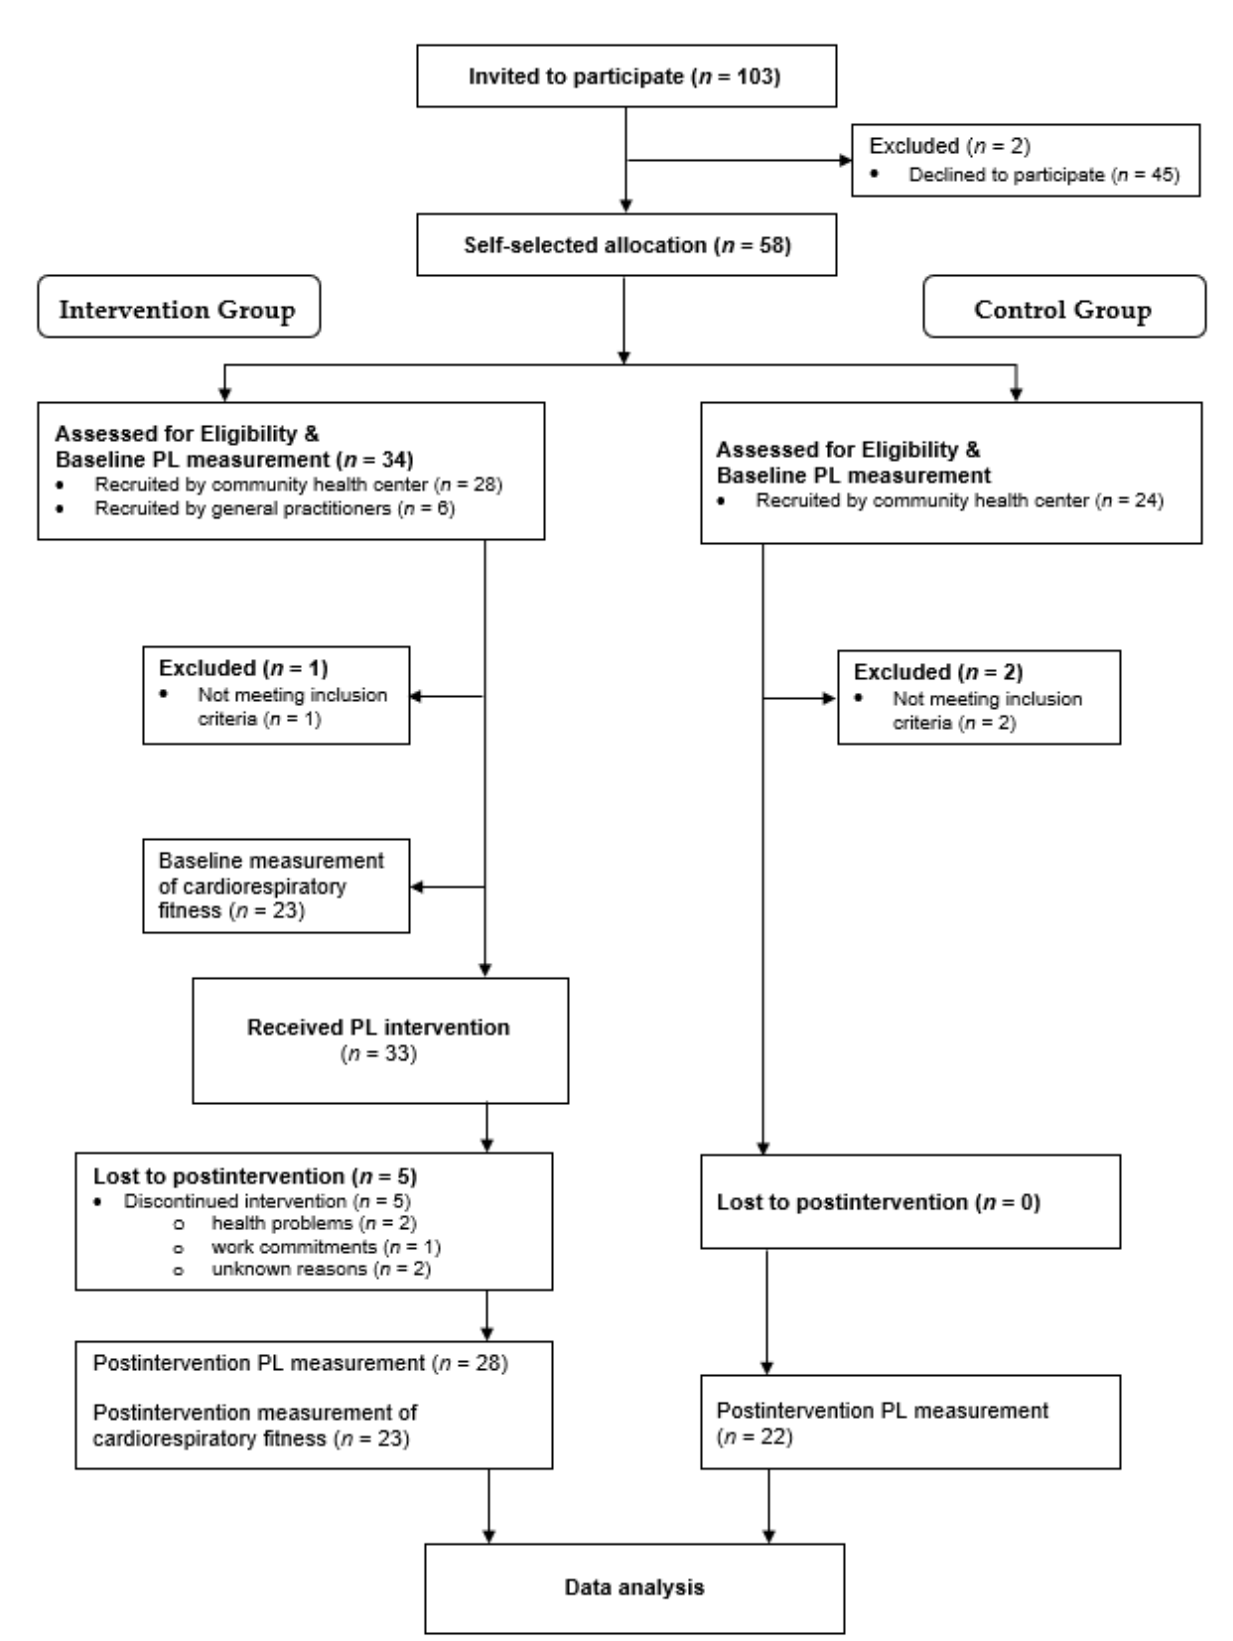
Figure 1. Flow diagram of recruitment numbers. PL: physical literacy.